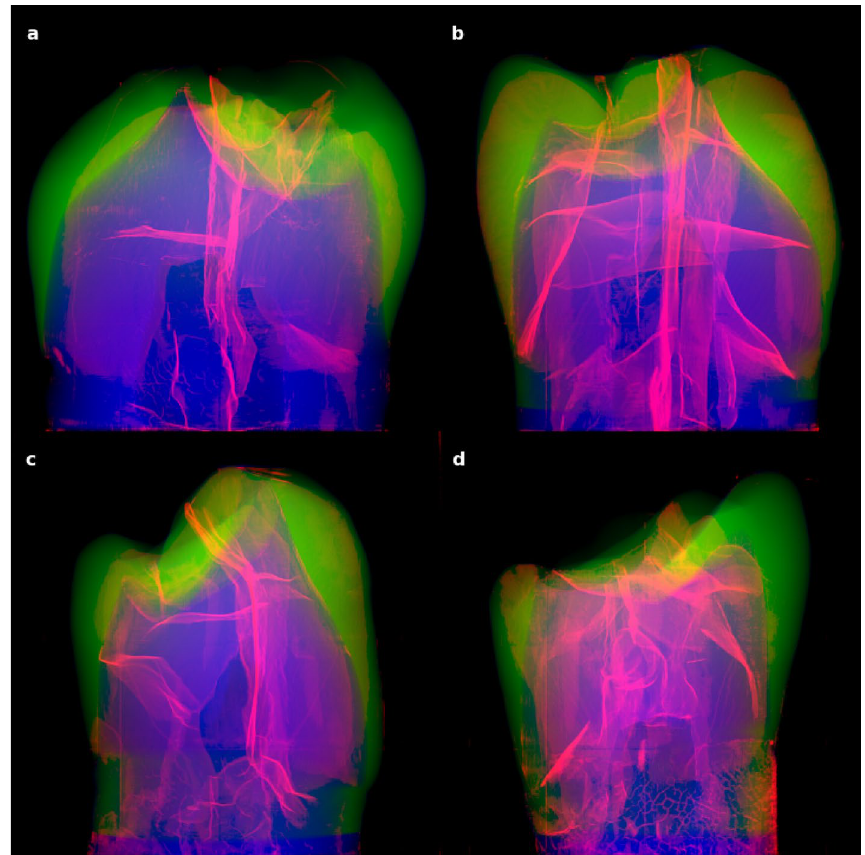
Figure 8. Four healthy teeth in our study sample ( a – d ) shown from random side views. X-ray µ CT data-cube projected density maps of convolutional neural network segmented enamel (green), dentin (blue), and cracks (red, intensity scaled as square root for enhancement) reveal an intricate inner